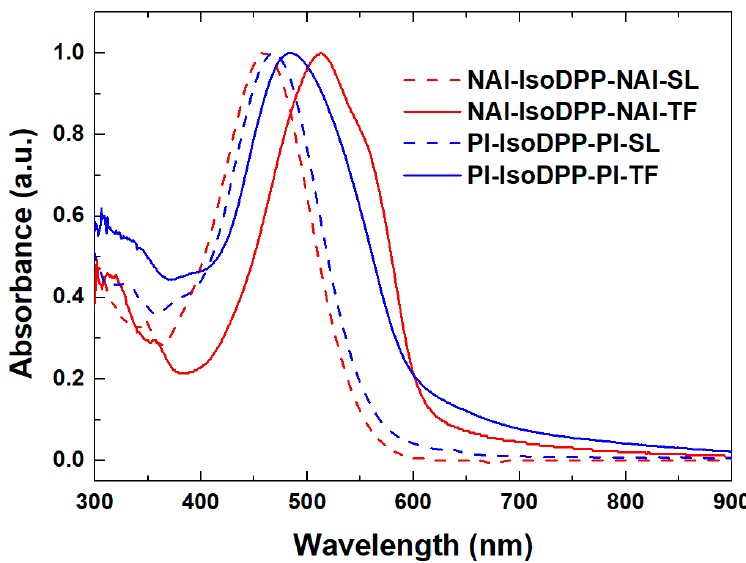
Figure 3. UV-visible absorption spectra of NAI-IsoDPP-NAI and PI-IsoDPP-PI in chloroform and thin film.